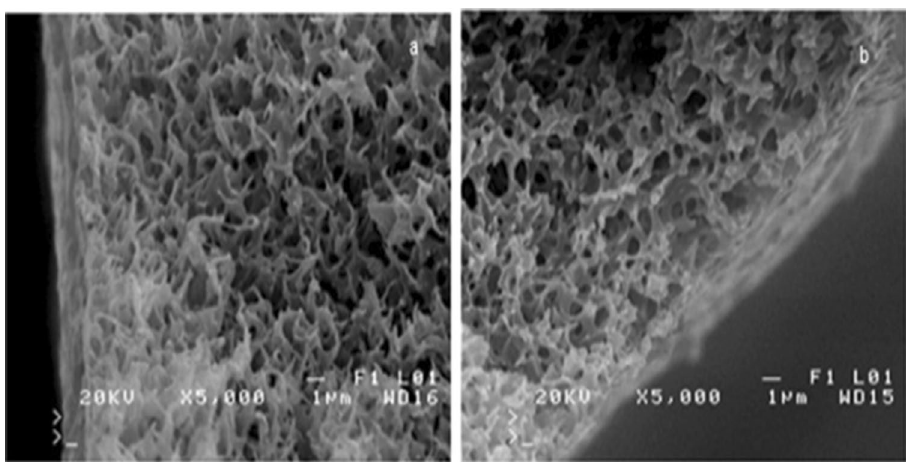
Fig. 14 SEM images of PTFE membranes